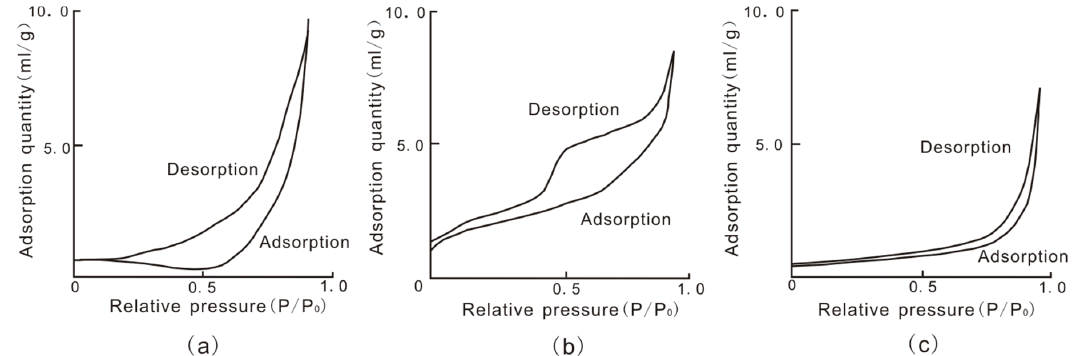
Figure 6. Three types adsorption-desorption curves of Niutitang Formation marine shales in northwestern Hunan. ( a ) Sample 1#; ( b ) Sample 10#; ( c ) Sample 5#.